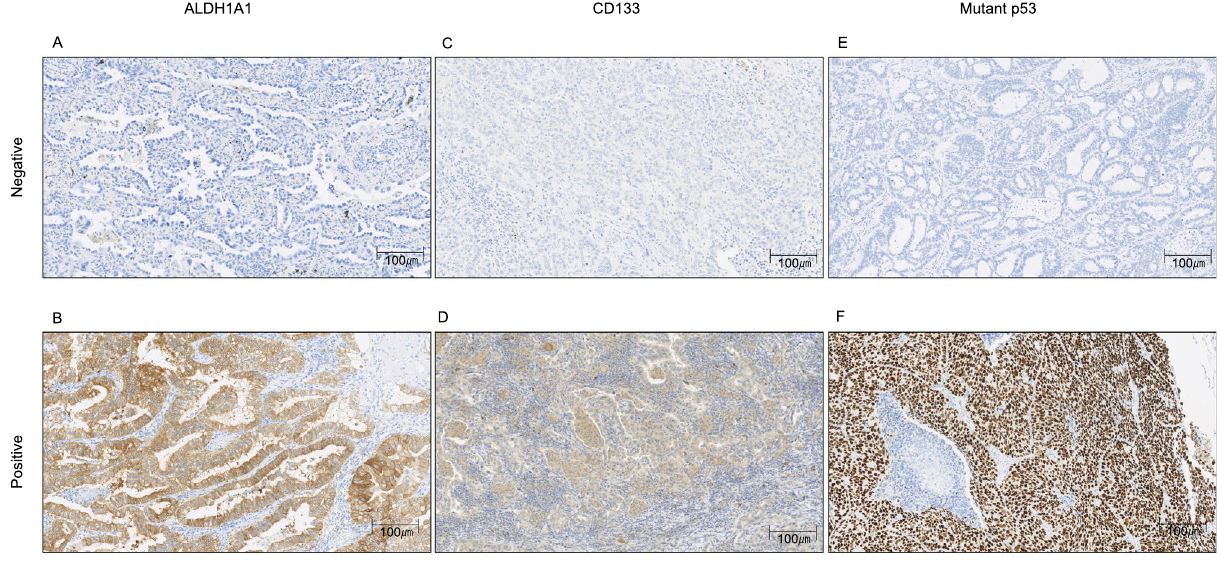
Figure 1. Immunohistochemical staining of ALDH1A1, CD133, and mutant p53 of samples from lung adenocarcinoma patients. ALDH1A1 staining intensity was rated as weak (1+), moderate (2+), or strong (3+) and multiplied by the percentage of positive cells. ALDH1A1 score = (% of cells of intensity 1 × 1) + (% of cells of intensity 2 × 2) + (% of cells of intensity 3 × 3). The total scores were categorized as follows: 0–100 = grade 1; 101–200 = grade 2; and 201–300 = grade 3. Grade 2 or 3 tumors were considered positive for ALDH1A1. ( A ) ALDH1A1 score = 0 (intensity 0 × 0% positive cells). ( B ) ALDH1A1 score = 220 (intensity 1 × 20% positive cells + intensity 2 × 30% positive cells + intensity 3 × 50% positive cells). The percentage of CD133- and mutant p53-positive cells was graded as 0%–100%. CD133 positivity was defined as staining of more than 20% of the tumor cells (negative: ≤ 20%; positive: > 20%). ( C ) CD133-positive cells were 0%, negative. ( D ) CD133-positive cells were 100%, positive. ( E ) Mutant p53-positive cells were 0%, negative. ( F ) Mutant p53-positive cells were 100%,